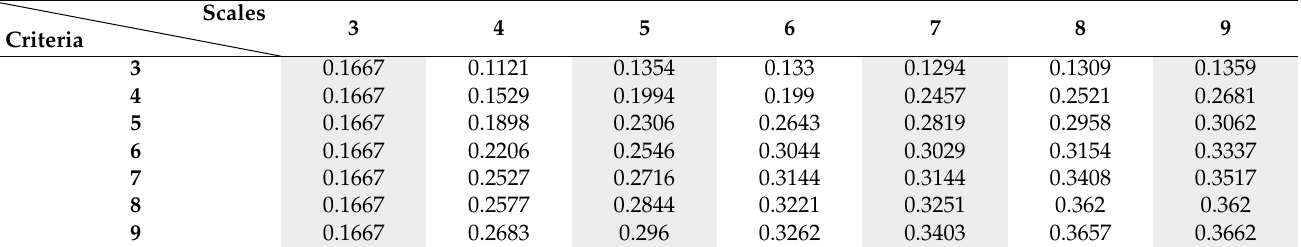
Table 6. Input-based consistency measurement threshold for various combinations according to